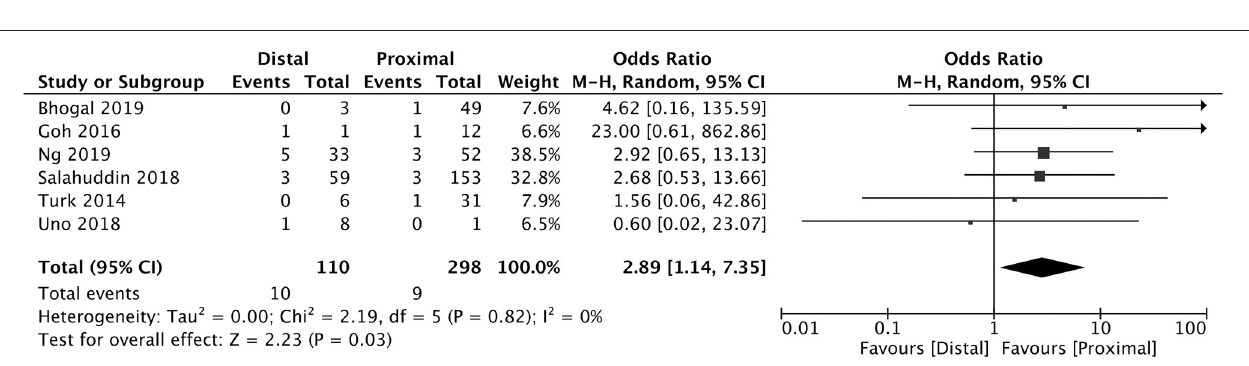
FIGURE 4 | Effect of proximal vs. distal vessel occlusion on subarachnoid hemorrhage following mechanical thrombectomy.